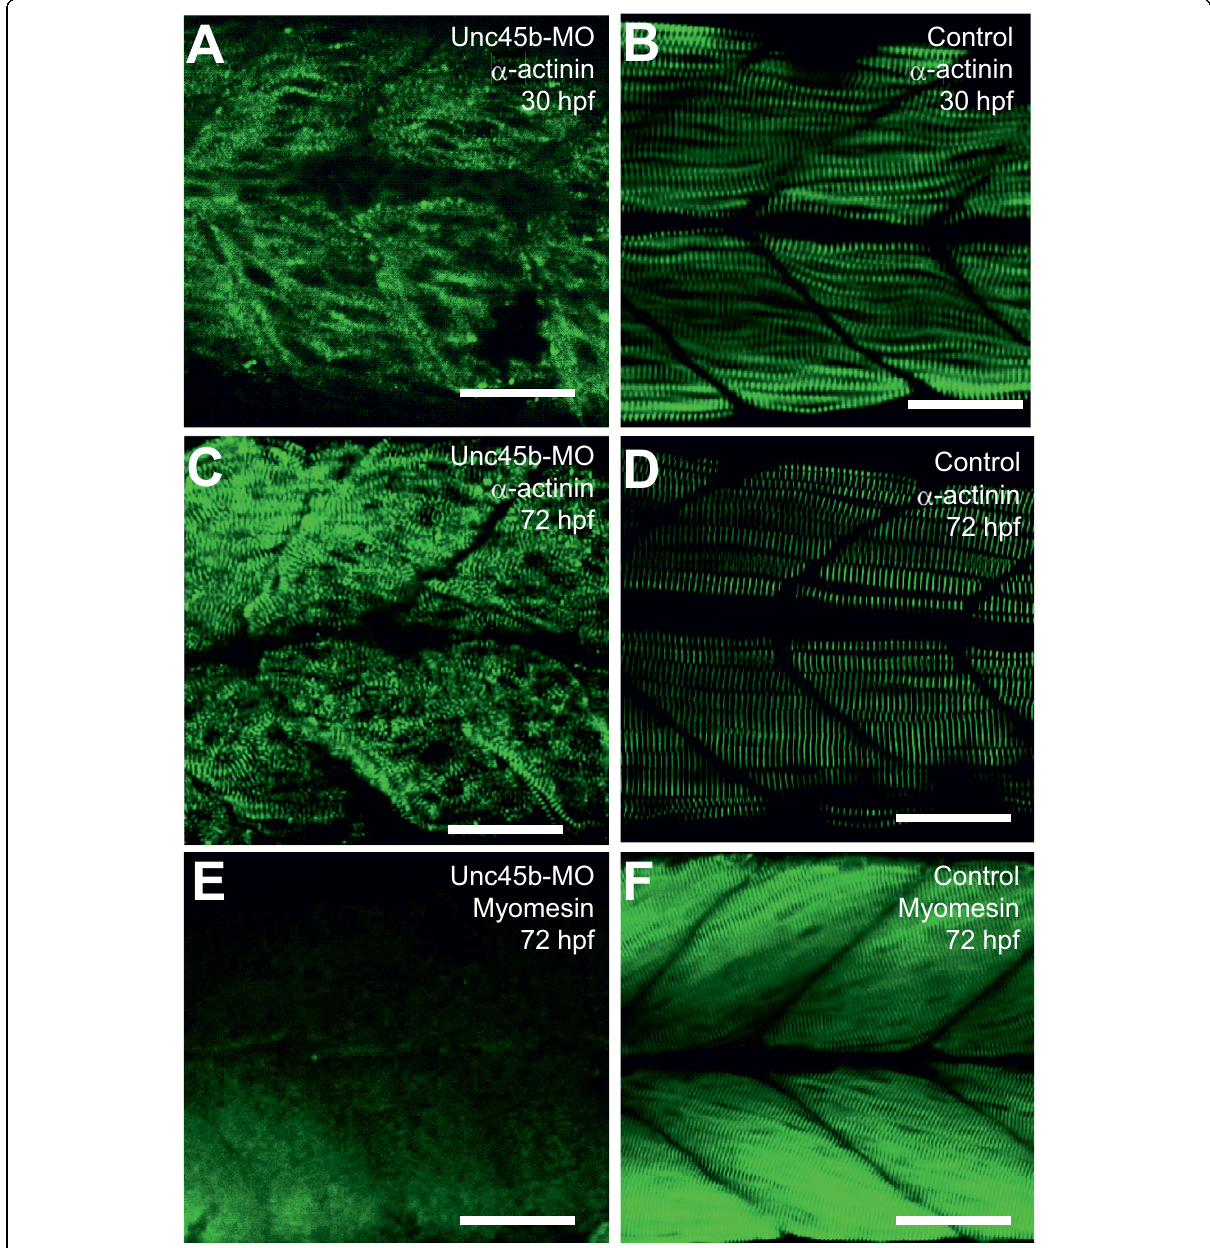
Figure 3 The effect of unc-45b knockdown on a -actinin and myomesin localization in skeletal muscles of zebrafish embryos . A-D . Anti- a -actinin antibody staining shows the Z-disc organization in unc-45b knockdown (A, C) or uninjecetd control (B, D) embryos at 30 (A, B) or 72 (C, D) hpf. E, F . Anti-myomesin antibody staining shows the M-line organization in unc-45b knockdown (E), or control (F) embryos at 72 hpf. Scale bars = 25 μ